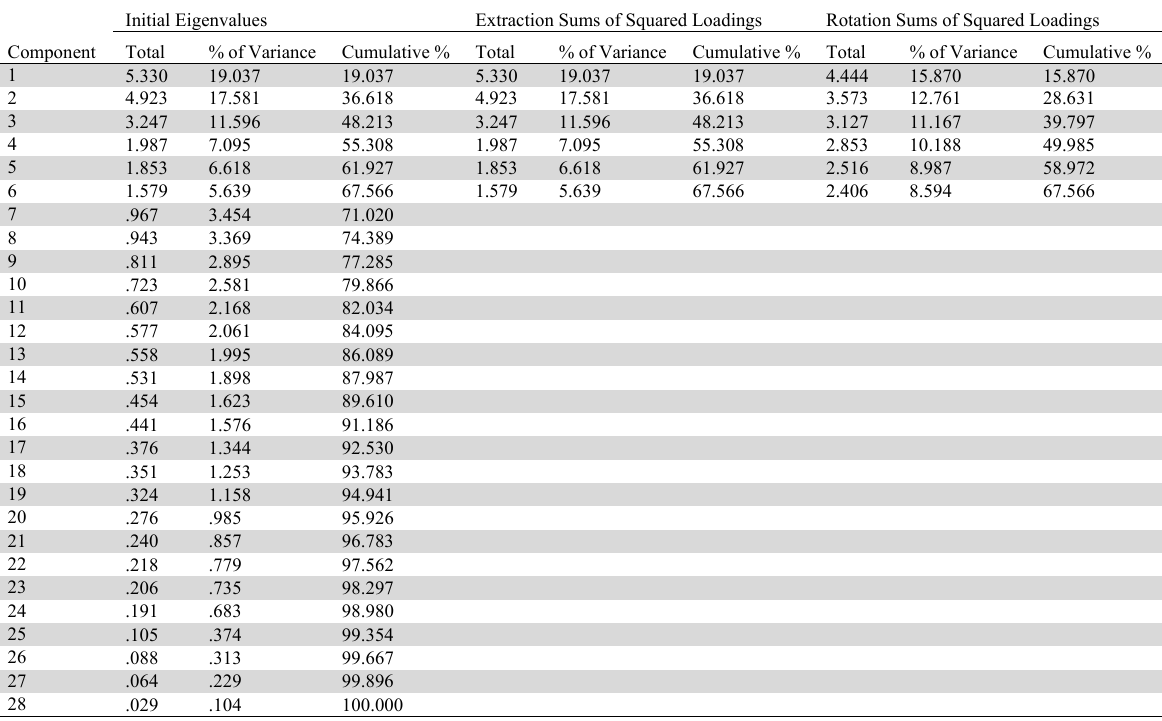
Total Variance Explained Initial Component